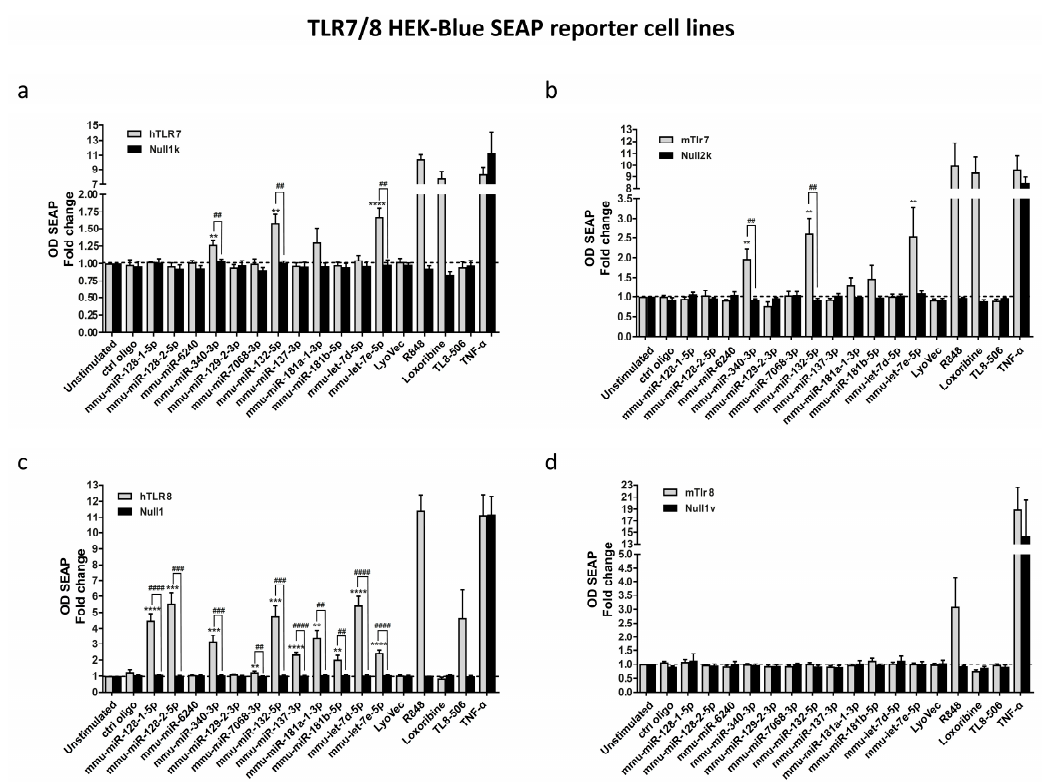
Figure 2. Extracellularly delivered miRNAs activate TLR7/8 in HEK293-derived TLR reporter cells. Human ( a , c ) or murine ( b , d ) TLR7 or TLR8 HEK-Blue-secreted embryonic alkaline phosphatase (SEAP) reporter cells and the corresponding null control cell lines were incubated with 10 µg/mL of the indicated synthetic oligoribonucleotides identified from small RNA sequencing analysis of supernatants from apoptotic neurons for 24 h. LyoVec and unstimulated cells served as negative controls, while loxoribine (TLR7), resiquimode (R848; TLR7/8) and TL8-506 (TLR8) served as positive control for the respective TLR reporter. Mutant oligoribonucleotide (ctrl oligo, 10 µg/mL) was used as a negative control. TNF was applied to activate the NF- κ B/AP-1 promoter in reporter and control cells. SEAP protein was detected at an optical density (OD) of 655 nm and depicted as fold change of the SEAP protein normalized to unstimulated control. (a) Response of human TLR7 HEK-Blue reporter and control cells (Null1k) to indicated miRNAs. (b) Response of murine TLR7 HEK-Blue reporter and control cells (Null2k) to indicated miRNAs. (c) Response of human TLR8 HEK-Blue reporter and control cells (Null1) to indicated miRNAs. (d) Response of murine TLR8 HEK-Blue reporter and control cells (Null1v) to indicated miRNAs. Depicted are n = 4–6 individual experiments. Significances were obtained by Student’s t -Test. (* p < 0.05, ** p < 0.01, *** p < 0.001, **** p < 0.0001; * compared to unstimulated control; # compared to HEK Null parental control cells). Data are represented as mean ± s.e.m.